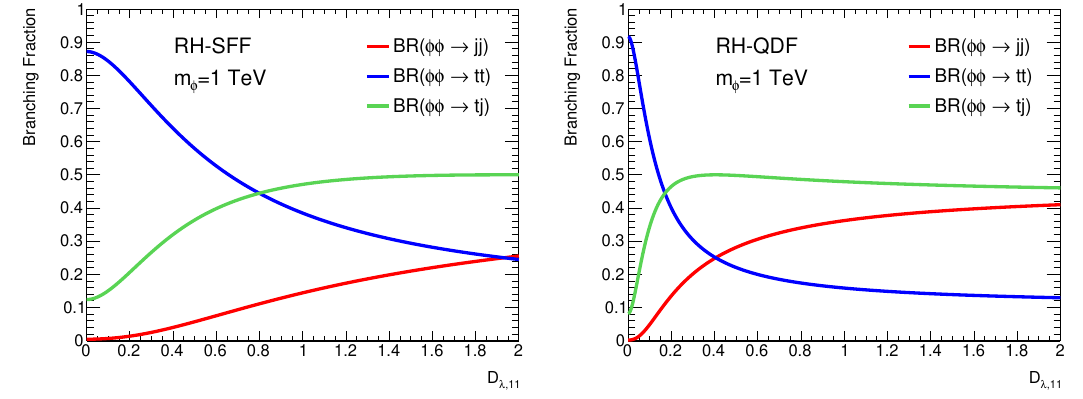
, tt + E miss and tj + E miss as T T T